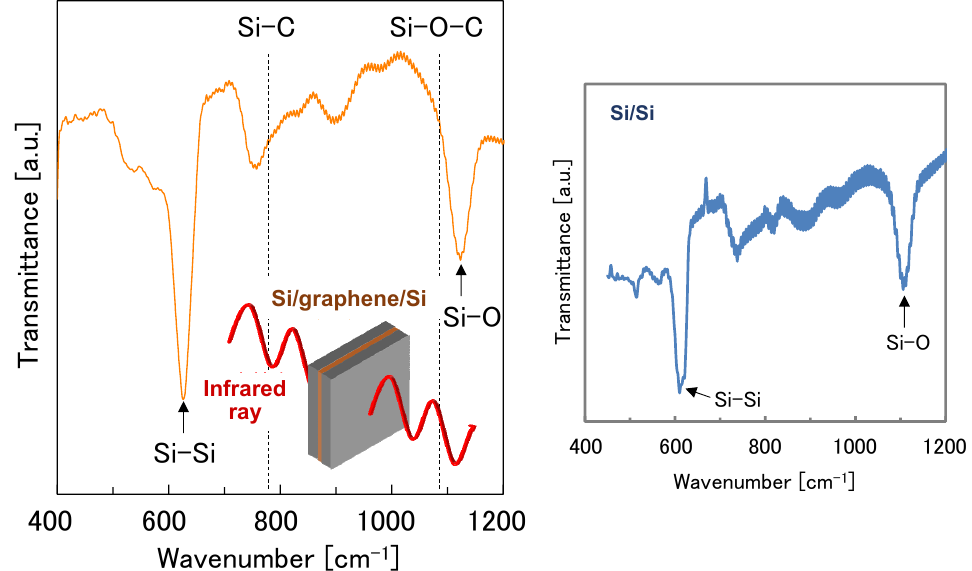
Figure 4. FTIR spectrum of ( left ) the Si/bilayer graphene/Si double heterostructure and ( right ) a Si/Si control structure.